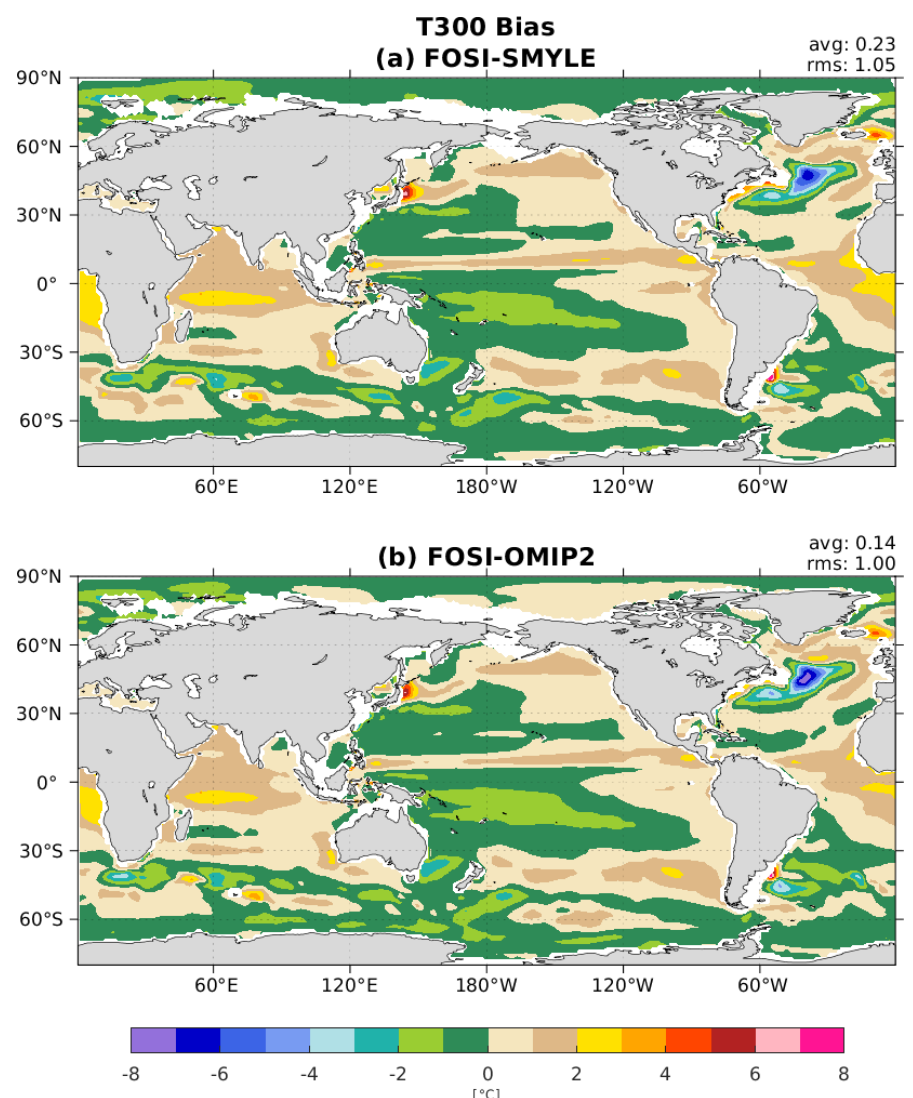
Figure A4. Climatological (1991–2010) upper 300m ocean temperature bias relative to EN4 from (a) FOSI-SMYLE and (b)